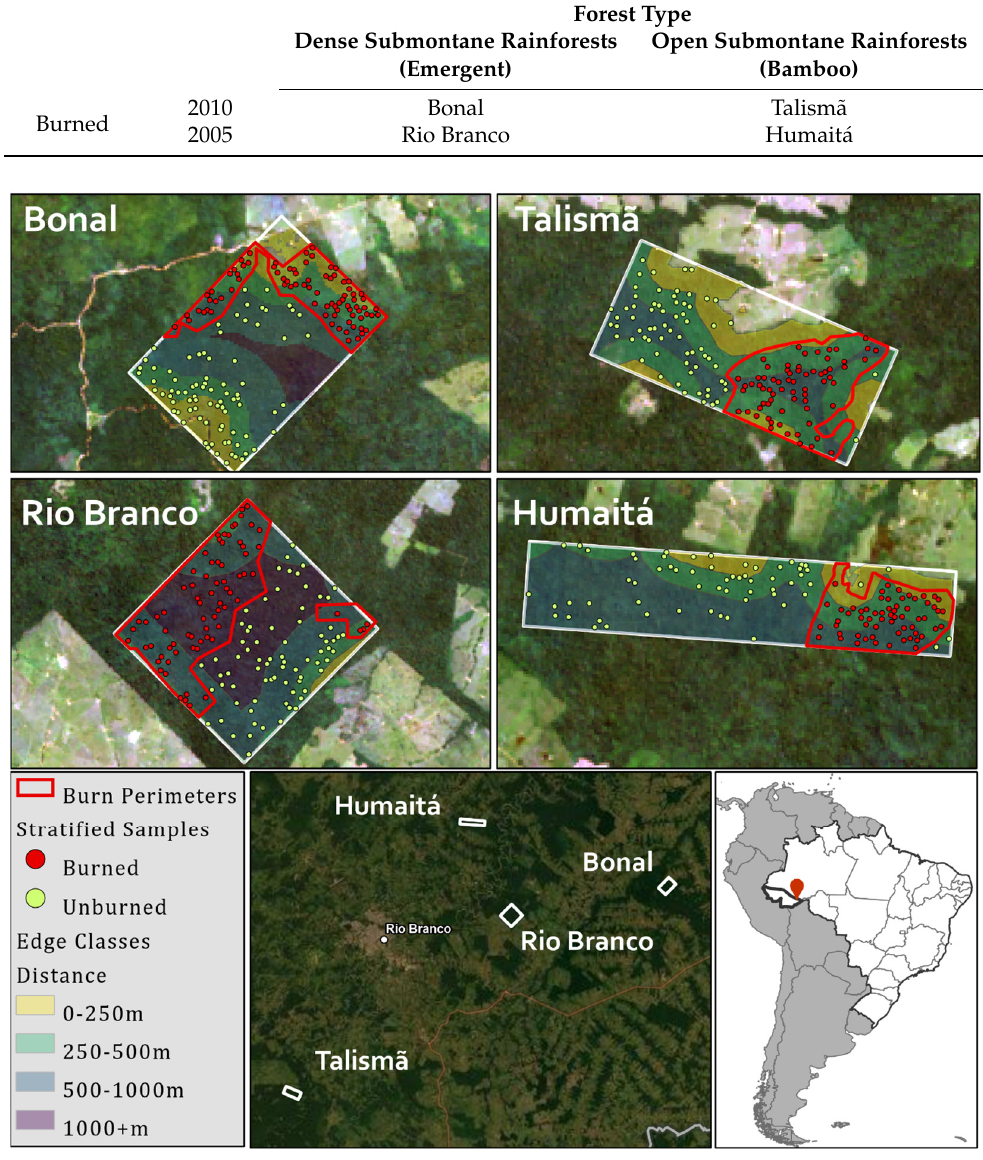
Table 1. Breakdown of the nuances of burned areas by forest type and year burned.